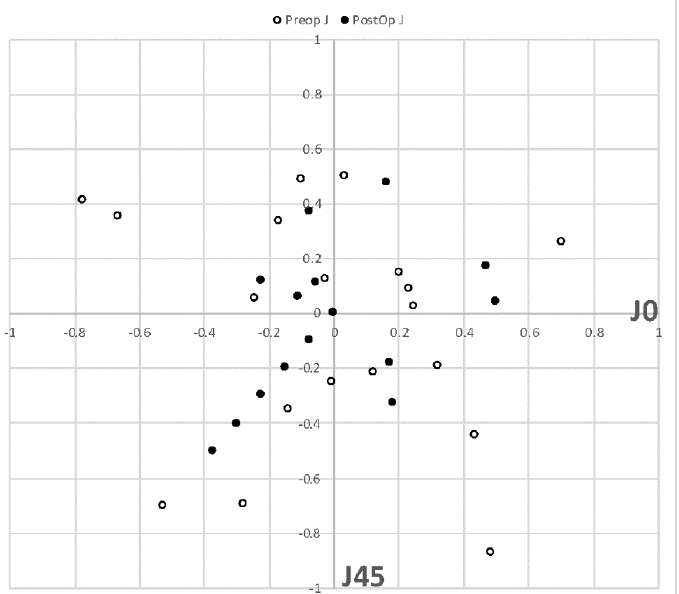
Figure 3. Distribution of residual astigmatism (D) scatterplot (J0 vs. J45). Empty bins represent preoperative data, and full black bins 3 months postoperation.